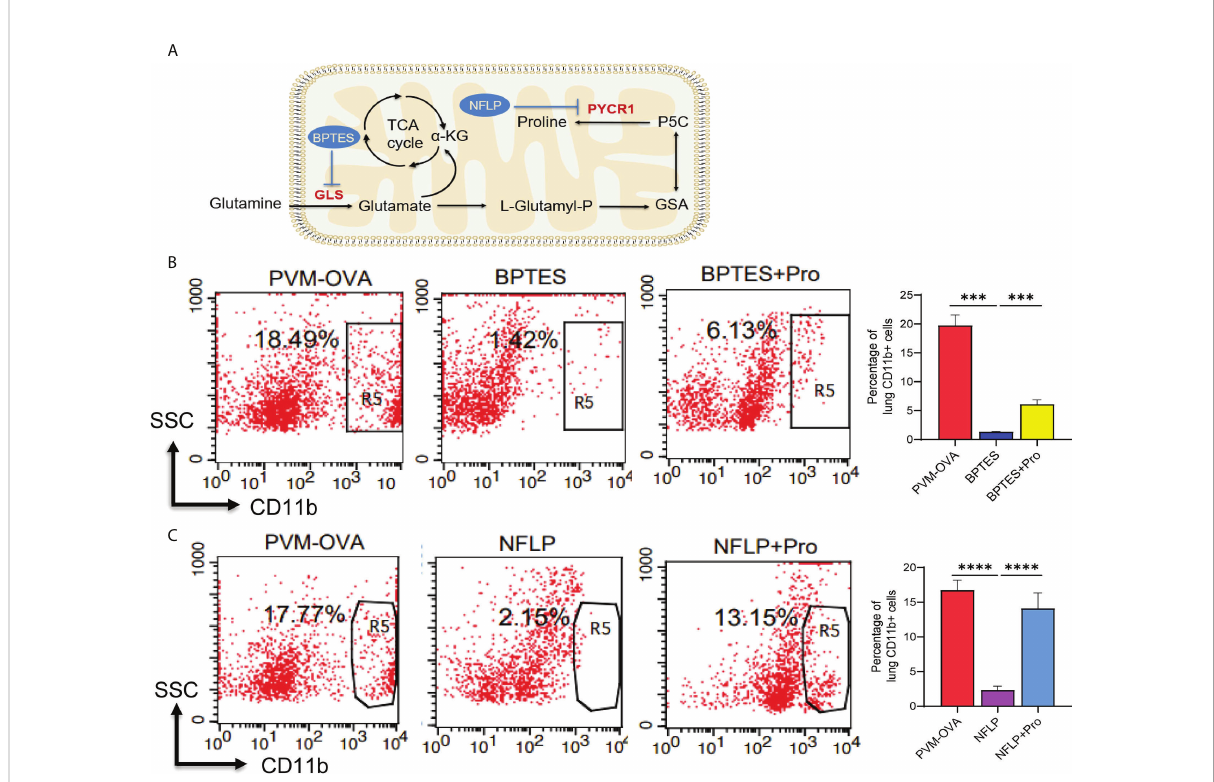
FIGURE 5 Proline metabolism plays a crucial role in development of the trained macrophages. (A) Diagram of proline synthesis from glutamine with inhibitors of key enzymes. (B, C) Mice were sensitized with PVM-OVA, PVM-OVA followed by BPTES or BPTES+Proline, or PVM-OVA followed by NFLP or NFLP+Proline. The lung CD11b+ trained macrophages in the memory phase were detected by fl ow cytometry (n = 5 per group). Each experimental group contained three biology repeats. ***P<0.001,